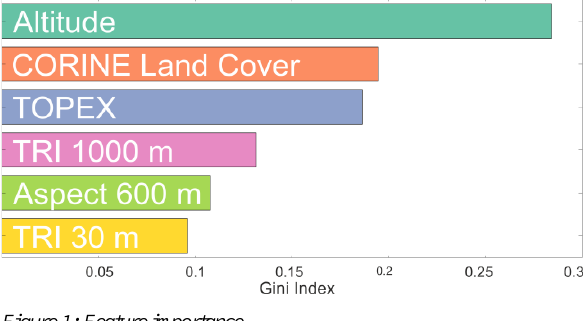
Figure 1: Feature importance